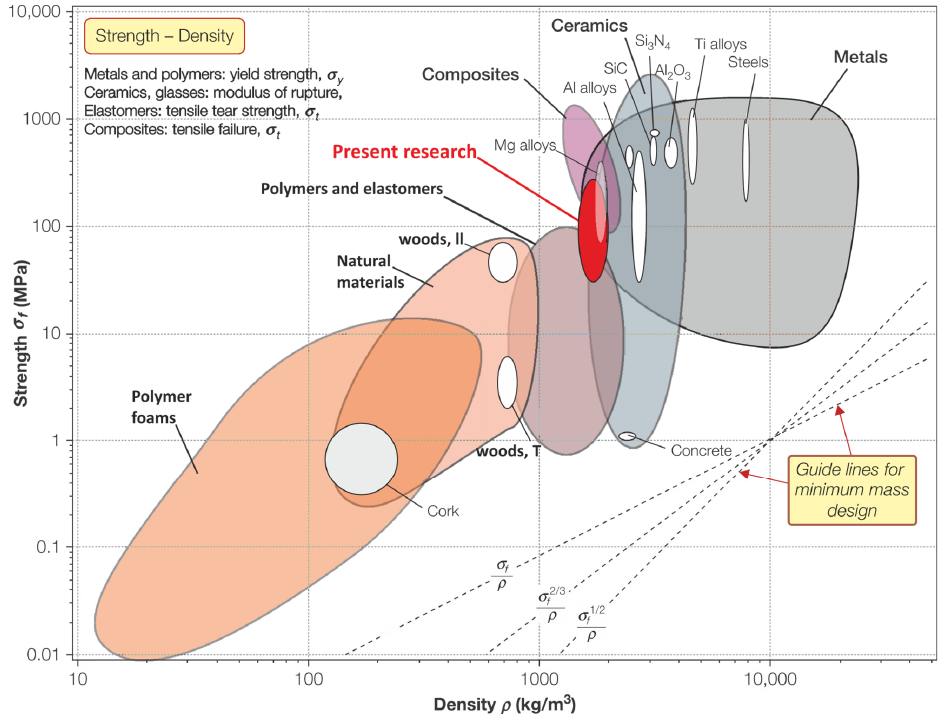
Figure 13. The compliance of produced clay-glass ceramic materials with typical materials demonstrated in the Ashby classification diagram (adopted with permission from [43]).